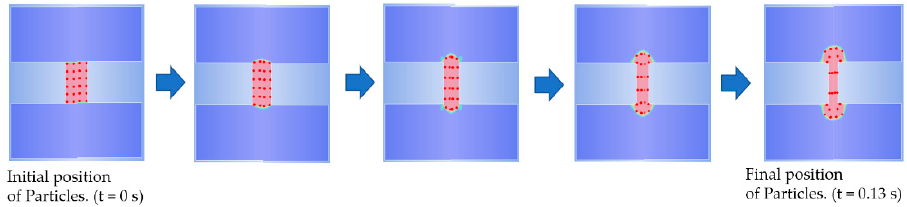
Figure 3. The distribution of inclusions during upsetting operation.